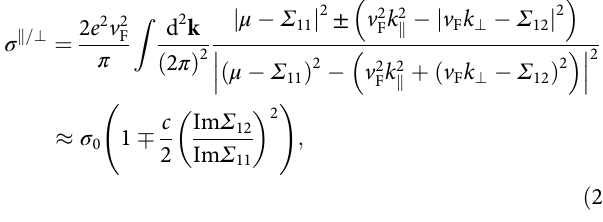
Fig. 2d inset), we obtain for our sample Γ 0 (cid:4) 50 meV, corre- sponding to a mean free path v F / Γ 0 of ~ 70 Å.